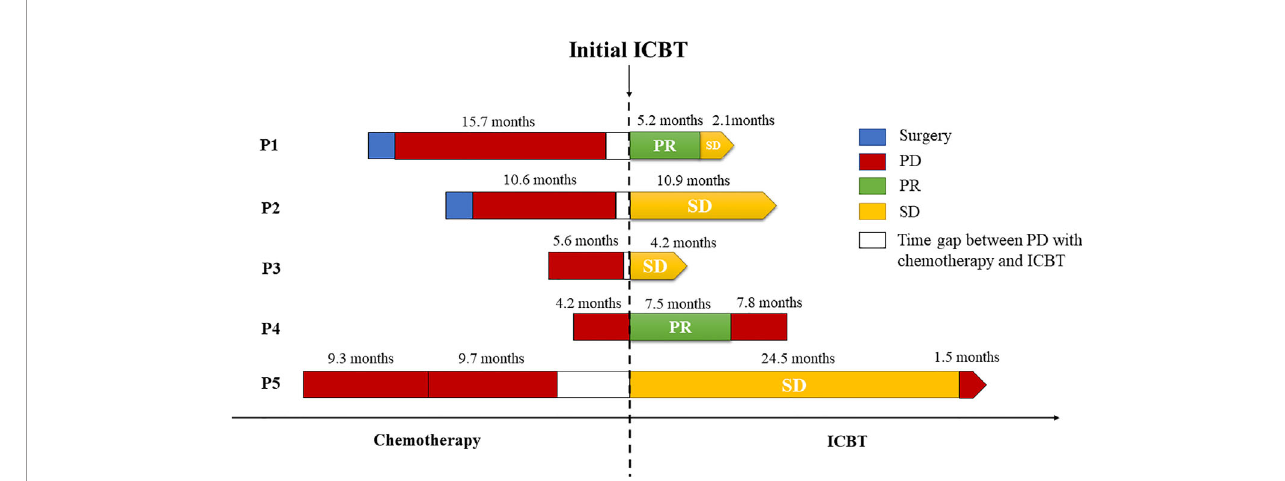
FIGURE 2 | Summary of treatment reactions to chemotherapy and immune checkpoint blockade therapy. All of the patients underwent PD before immunotherapy, and three of them responded favorably to ICBT. The bars on the left and right side of the dotted line denote the treatment details before and after the administration of immune checkpoint inhibitors,